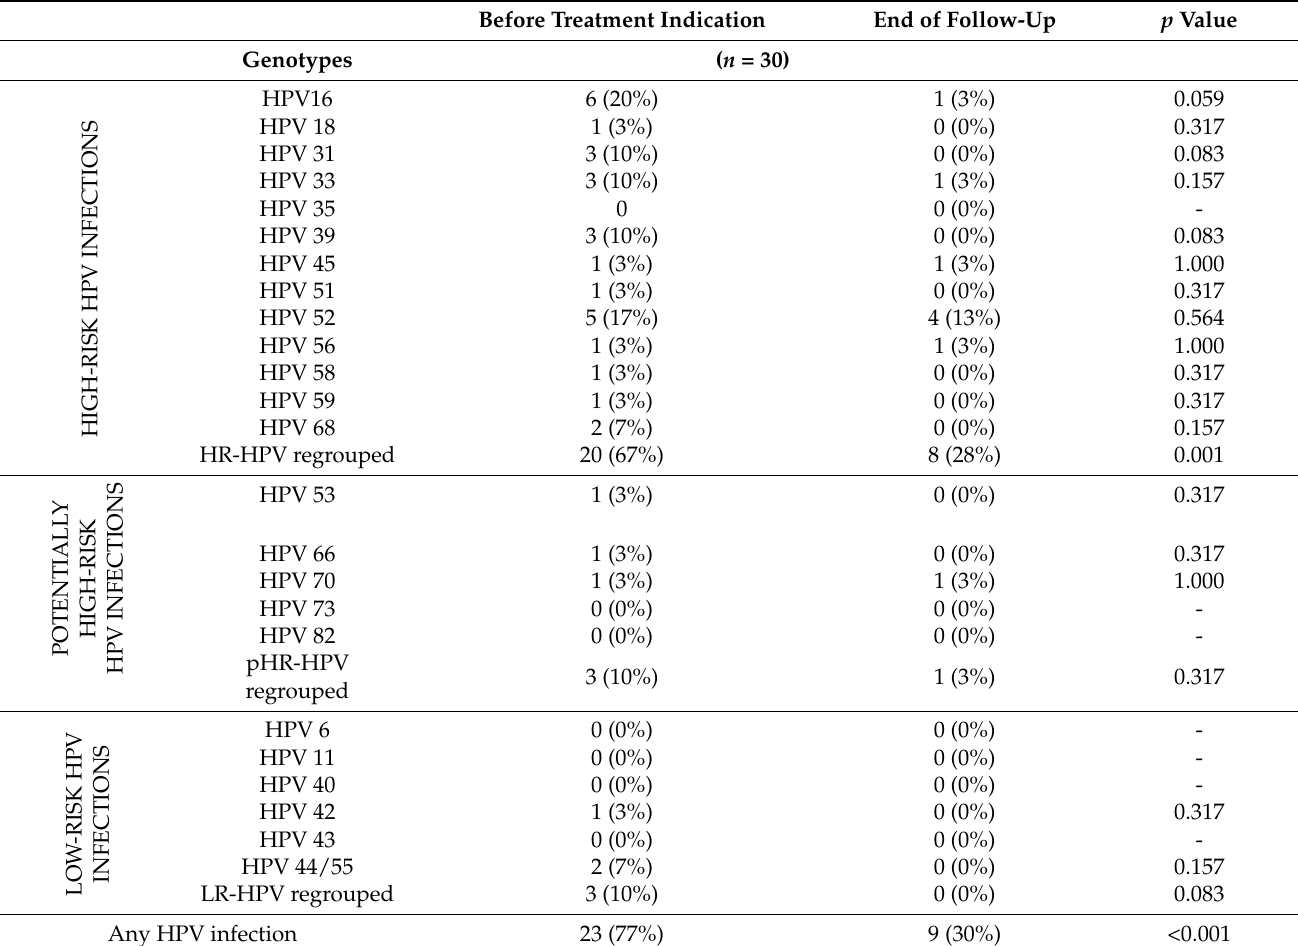
Table 2. Prevalence of HPV infection at the time of indication and by the end of the follow-up, among women who received treatment for a cervical